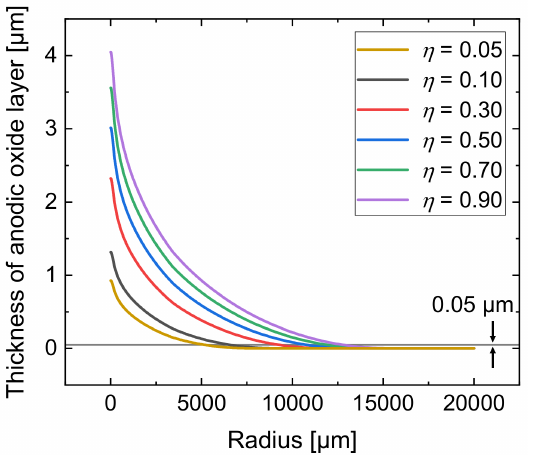
Figure 8. Simulated total anodic oxide thickness after 10 min of the jet-based anodization for different current efficiencies η